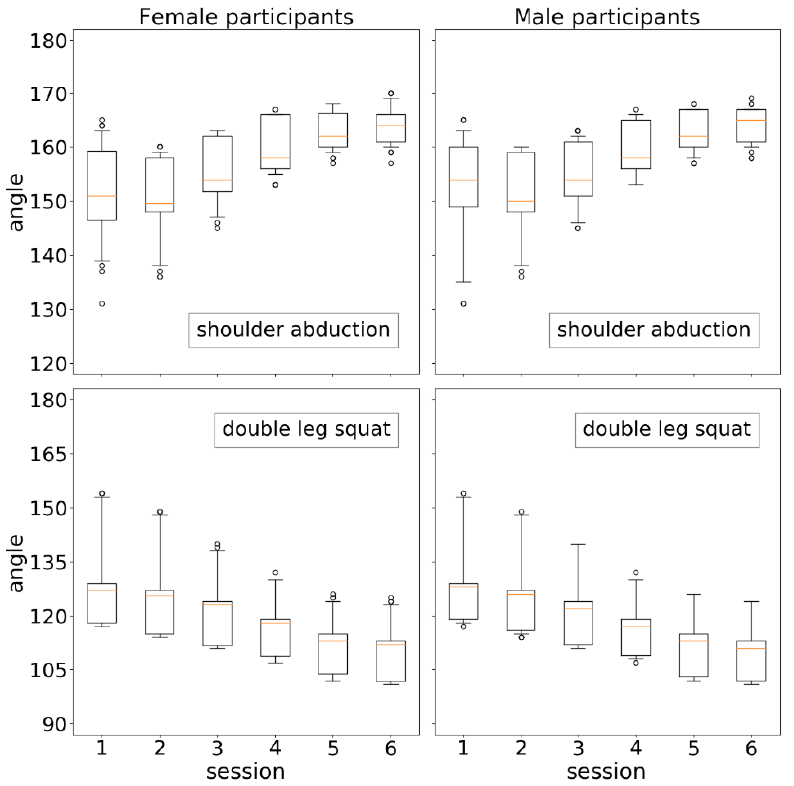
Figure 20. Distributions of exercise results by session from a gender perspective.